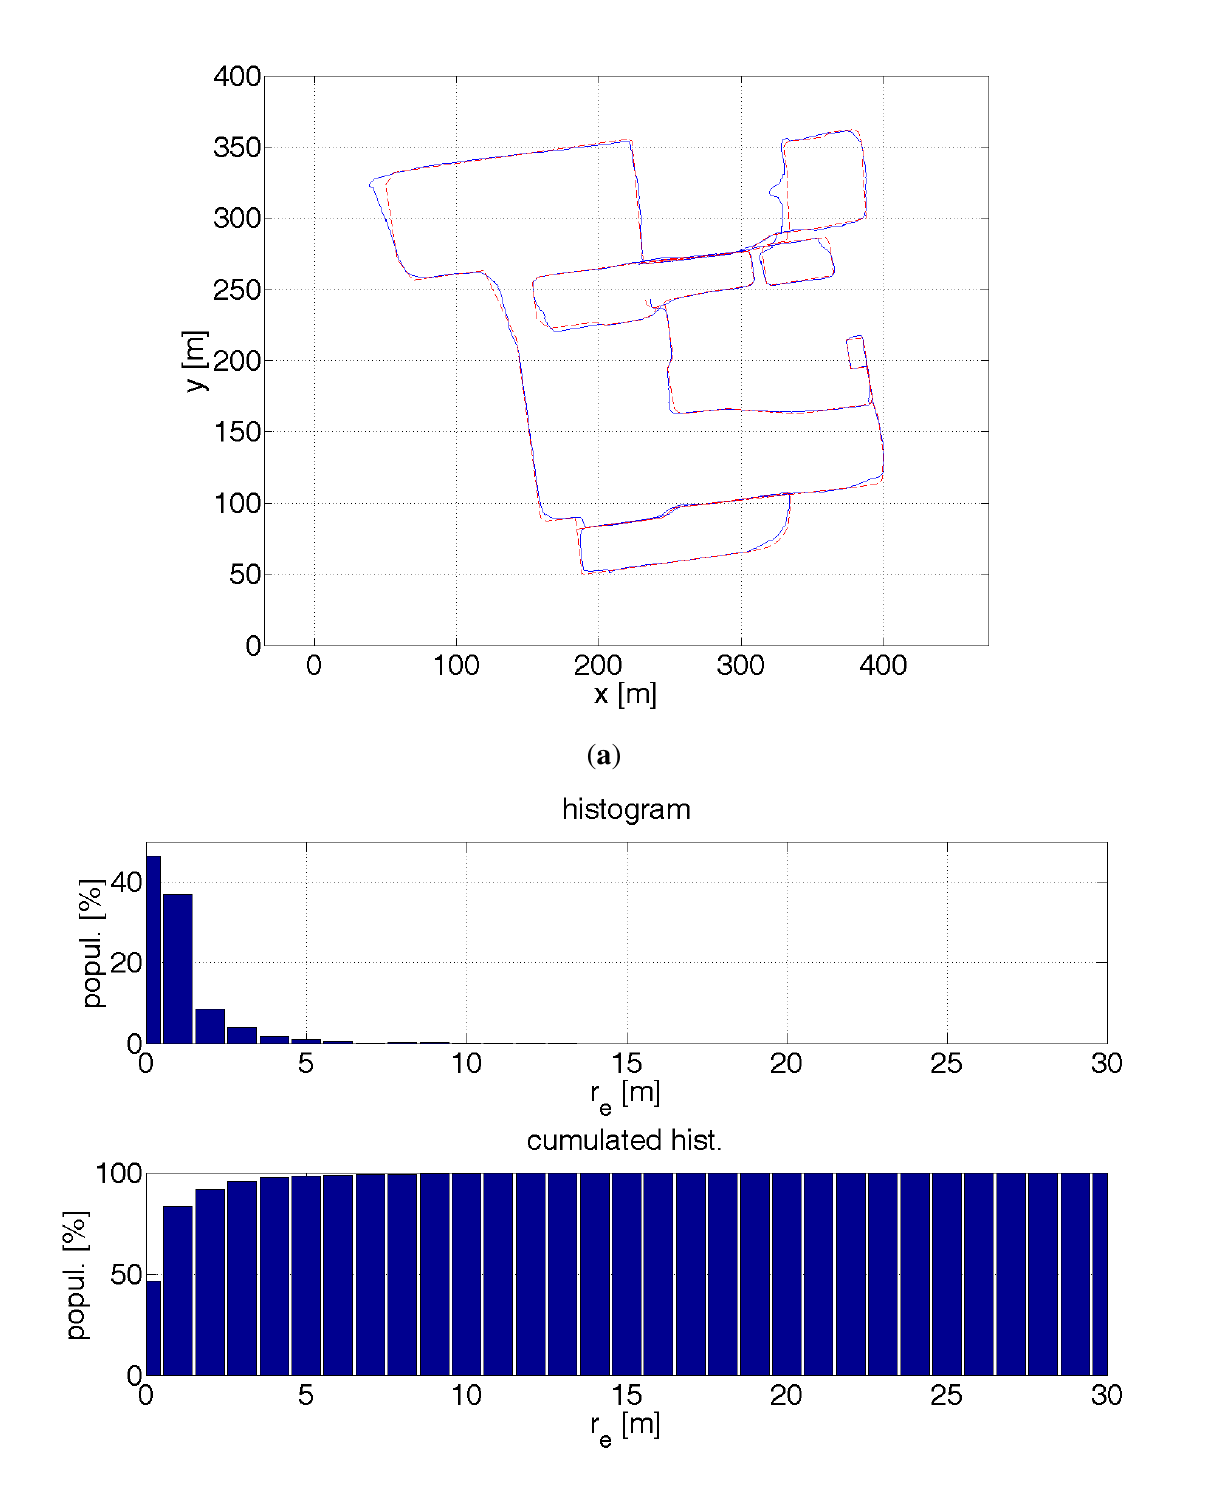
Figure 20. ( a ) Red dashed line—reference path. Blue solid line—estimated path with a help of inertial sensors, probability map, stereo camera and 3D model of the environment. When the initial position is known, the filter can estimate the pedestrian location with smaller errors than the GPS receiver. ( b ) Histograms of distance